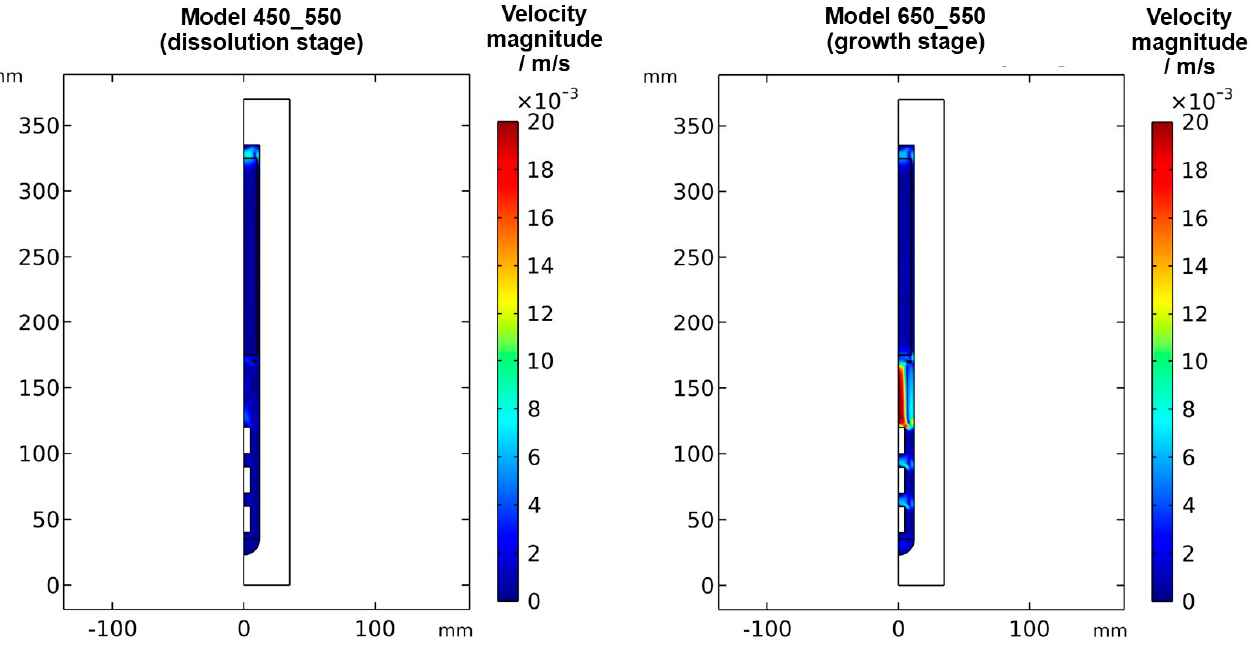
Figure 6. Velocity magnitude at dissolution stage (left) and growth stage (right) in a quasi-stable